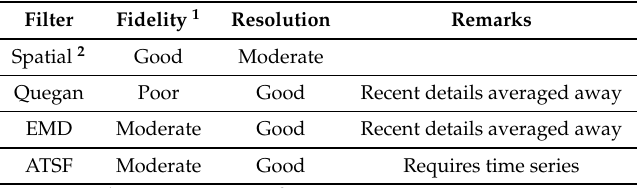
Table 3. Qualitative comparison of despeckling